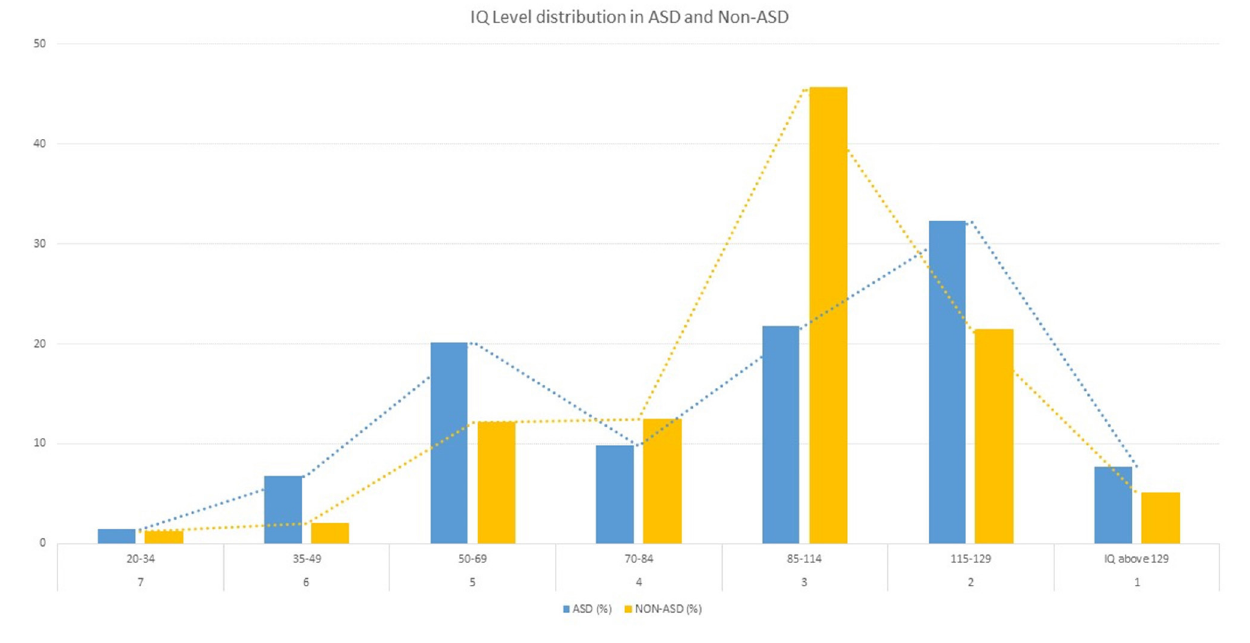
FIGURE 1 | IQ level distribution (from IQ level 7-1 in %) of ASD (n = 440) and non-ASD (n = 644) group in a German sample referred to specialized ASD